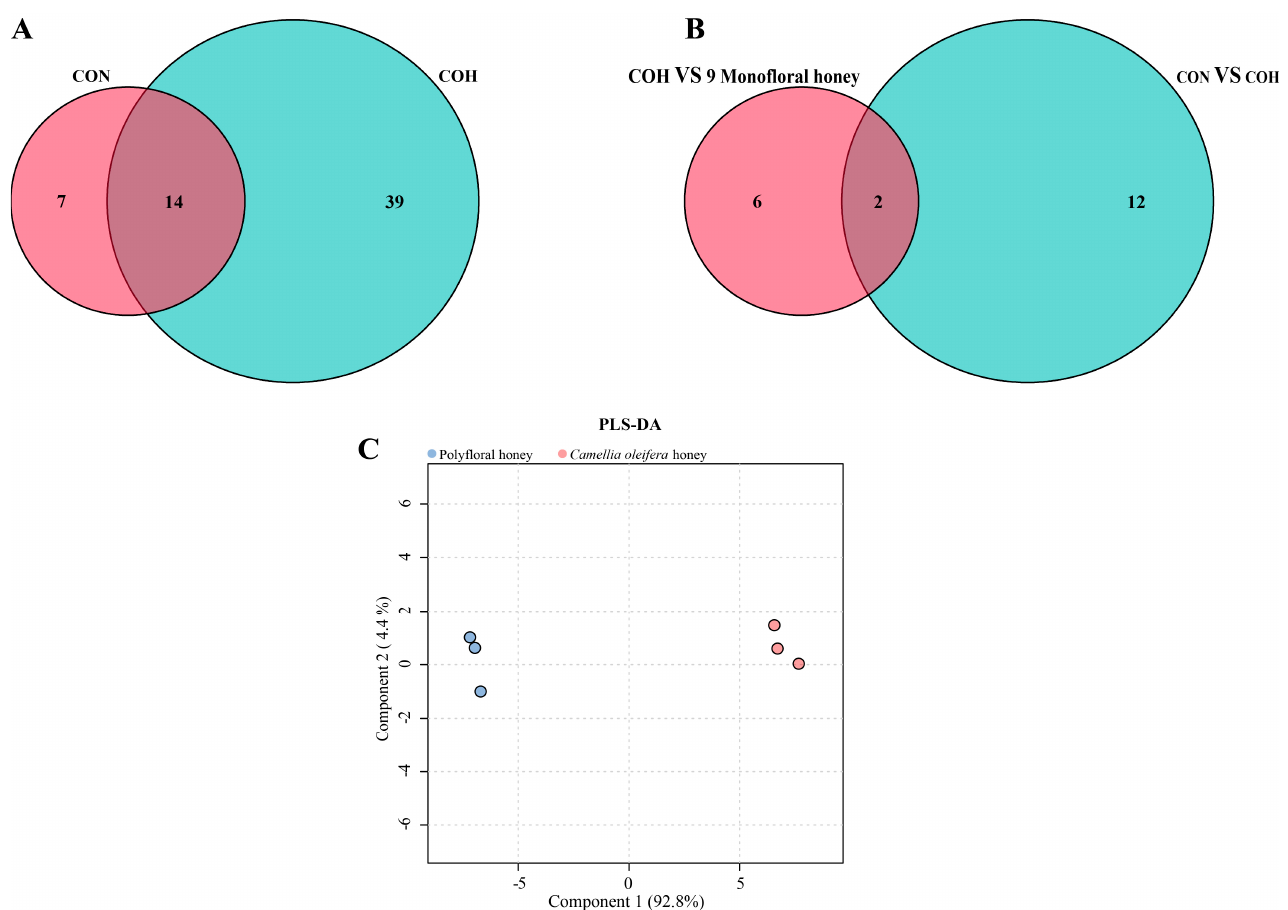
Figure 2. ( A ) The flavonoid species that are shared in C. oleifera honey (COH) and C. oleifera nectar (CON). ( B ) Flavonoids distinctive to C. oleifera honey (COH) and nectar relative to 9 types of monofloral honey. ( C ) PLS-DA of the flavonoid compounds determined by LC-MS/MS of samples of polyfloral and C. oleifera honey. The first PLS component explains 92.8% (Component 1) and the second PLS component 4.4% (Component 2) of the variation of the data.